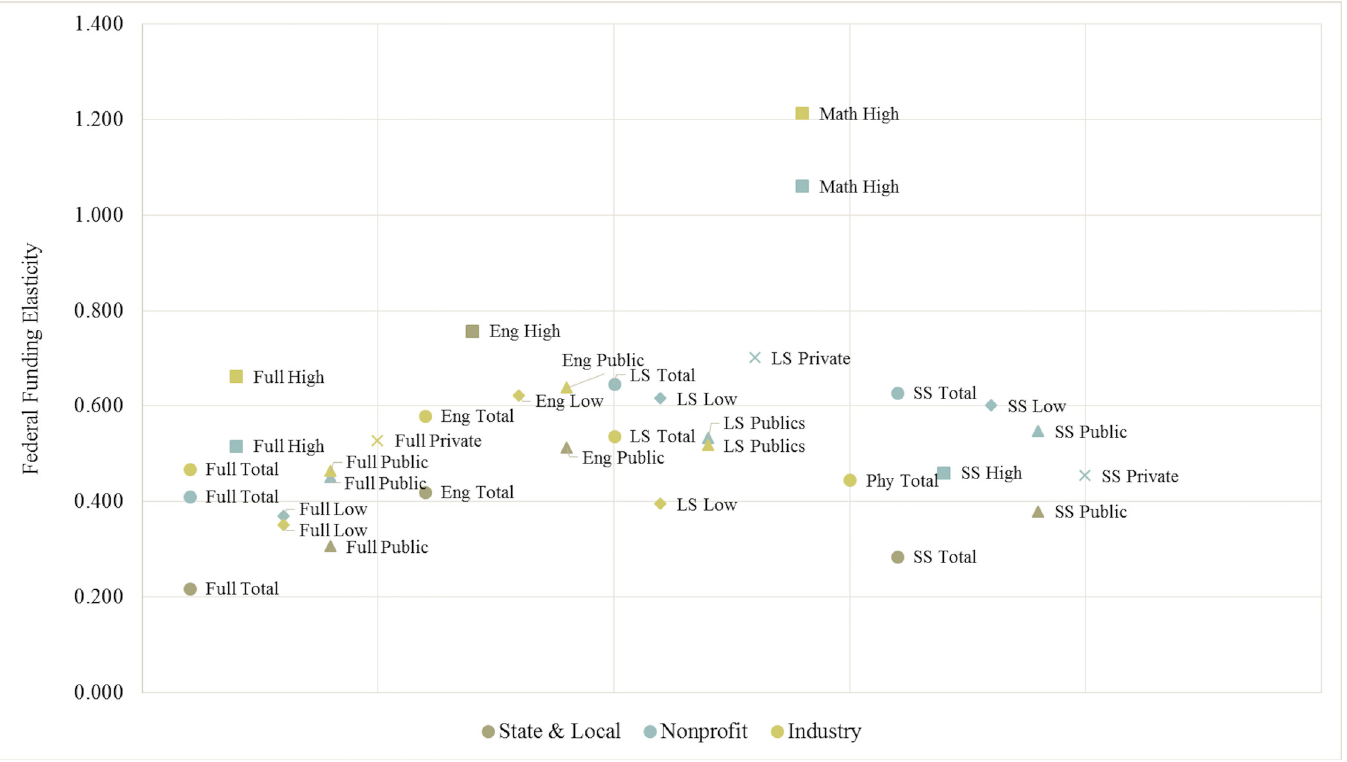
Fig 5. Robust Significant Federal Elasticities by Outcome & Stratification. Notes : Elasticities from Eq 1 estimations. Elasticity values are presented only if the results for the primary outcome – federal R&D funding – are efficient and consistent to the following additional model specifications: the alternate dynamic panel model (Eq 4), and the fixed effects model (Eq 2). The key for Fig 5 is presented directly above. The y-axis denotes the elasticity values, while the x-axis does not indicate any value but rather allows for the presentation of the myriad results. Additionally, Table 7 serves as a reference guide for the output in Fig 5. The left column denotes the abbreviations for the Fields and the right column references the various stratification and its corresponding referenced object in Fig 5.